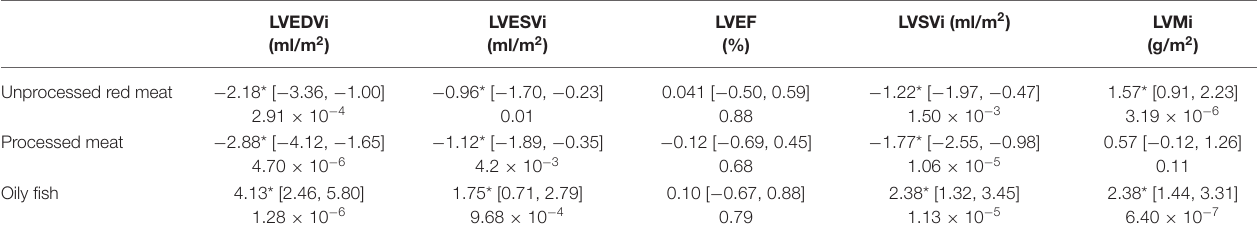
TABLE 2 | Multivariable linear regression models showing change in LV conventional CMR indices per 100g increase in daily meat/fish consumption.